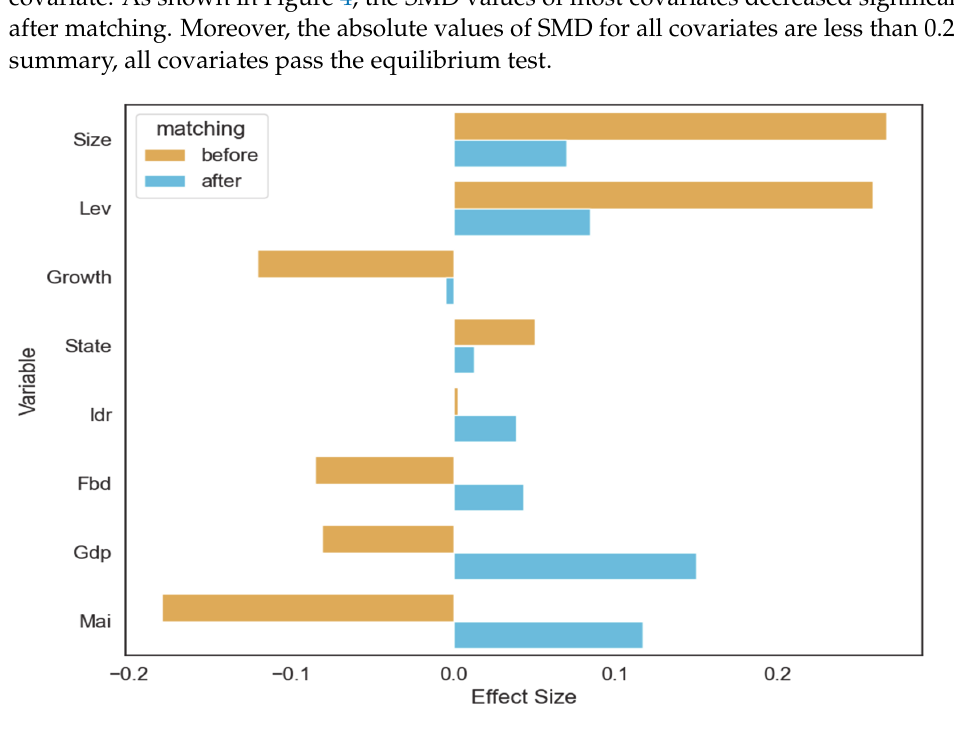
Table 3. Test for causal effects after matching.